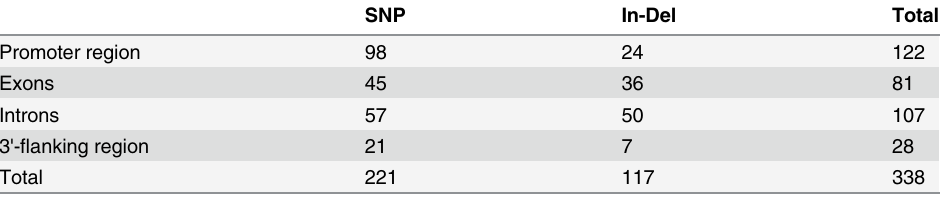
Table 1. Sequence polymorphism of Ma 3 gene detected in all 252 materials